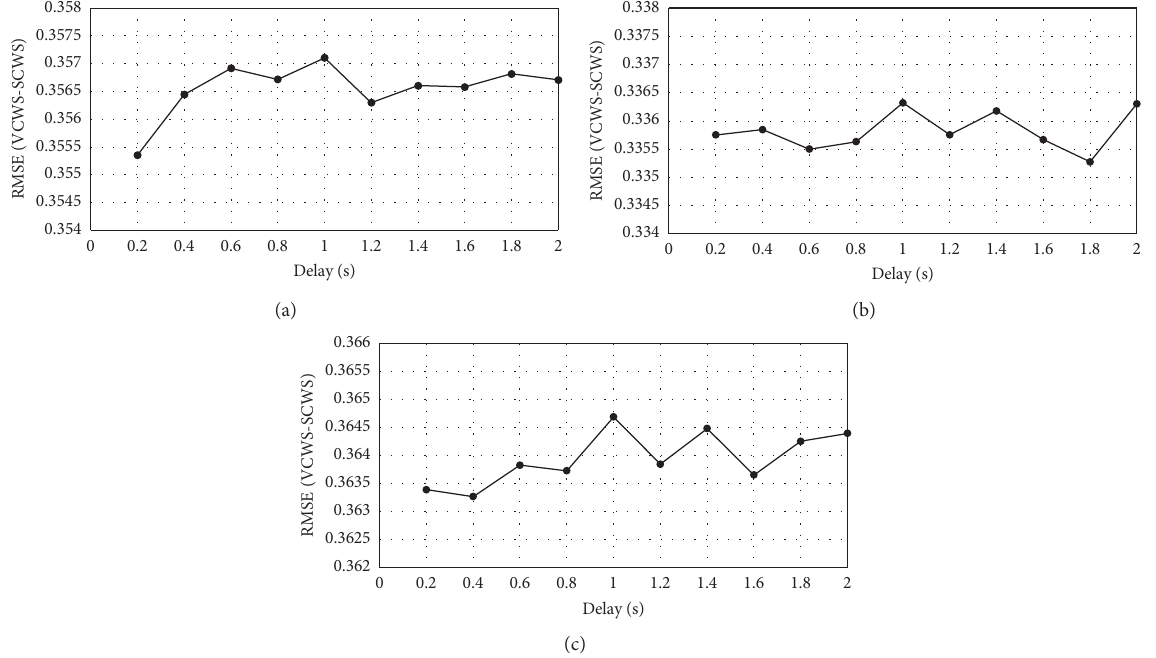
Figure 8: Effect of time delay on the RMSE between the VCWS and the SCWS for (a) Case 1, (b) Case 2, and (c) Case